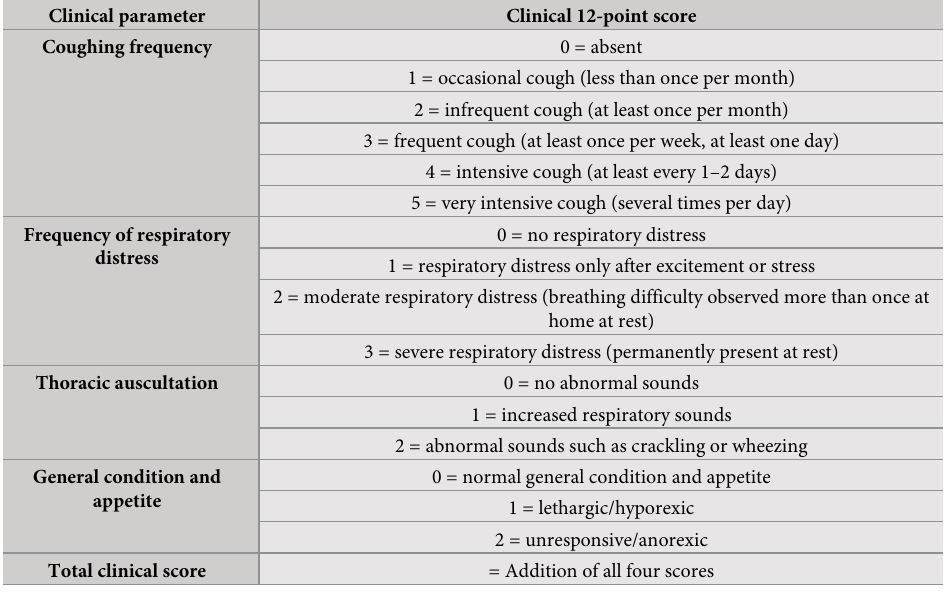
Table 1. Clinical 12-point score in cats with